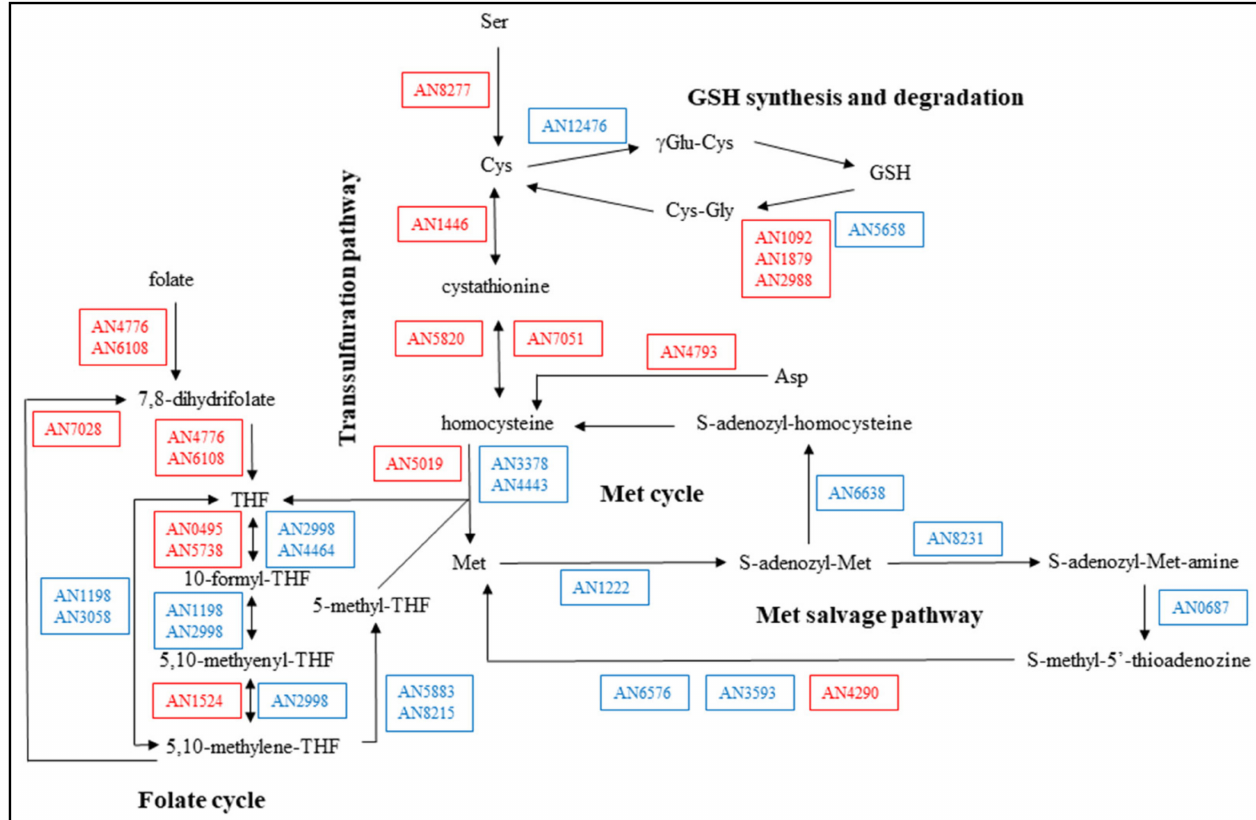
Figure 3. Changes in the Cys and Met metabolism under CdCl 2 treatment in the A. nidulans THS30 reference strain. Up-regulated genes are marked with red, down-regulated genes with